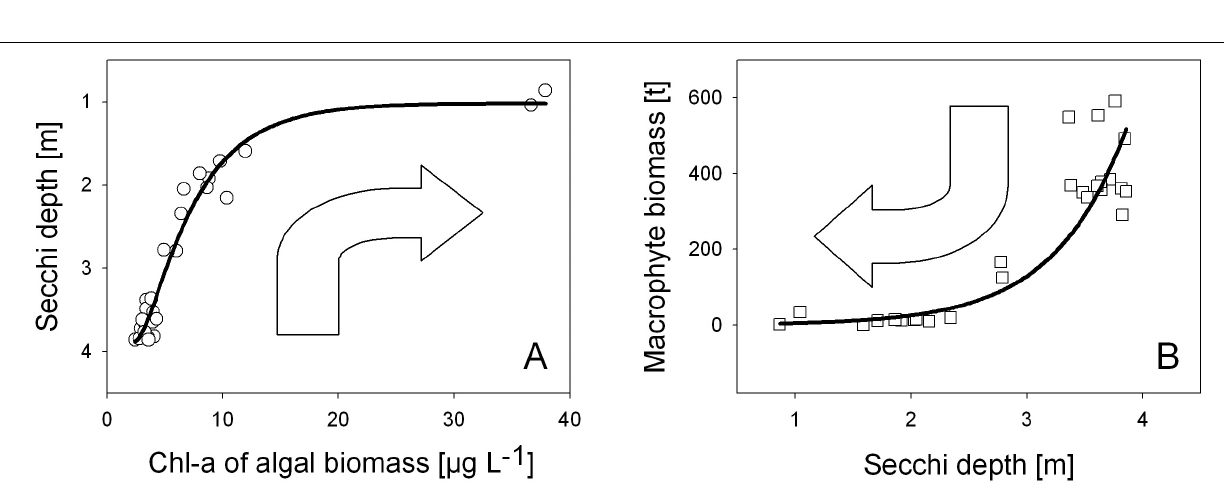
Frontiers in Environmental Science |